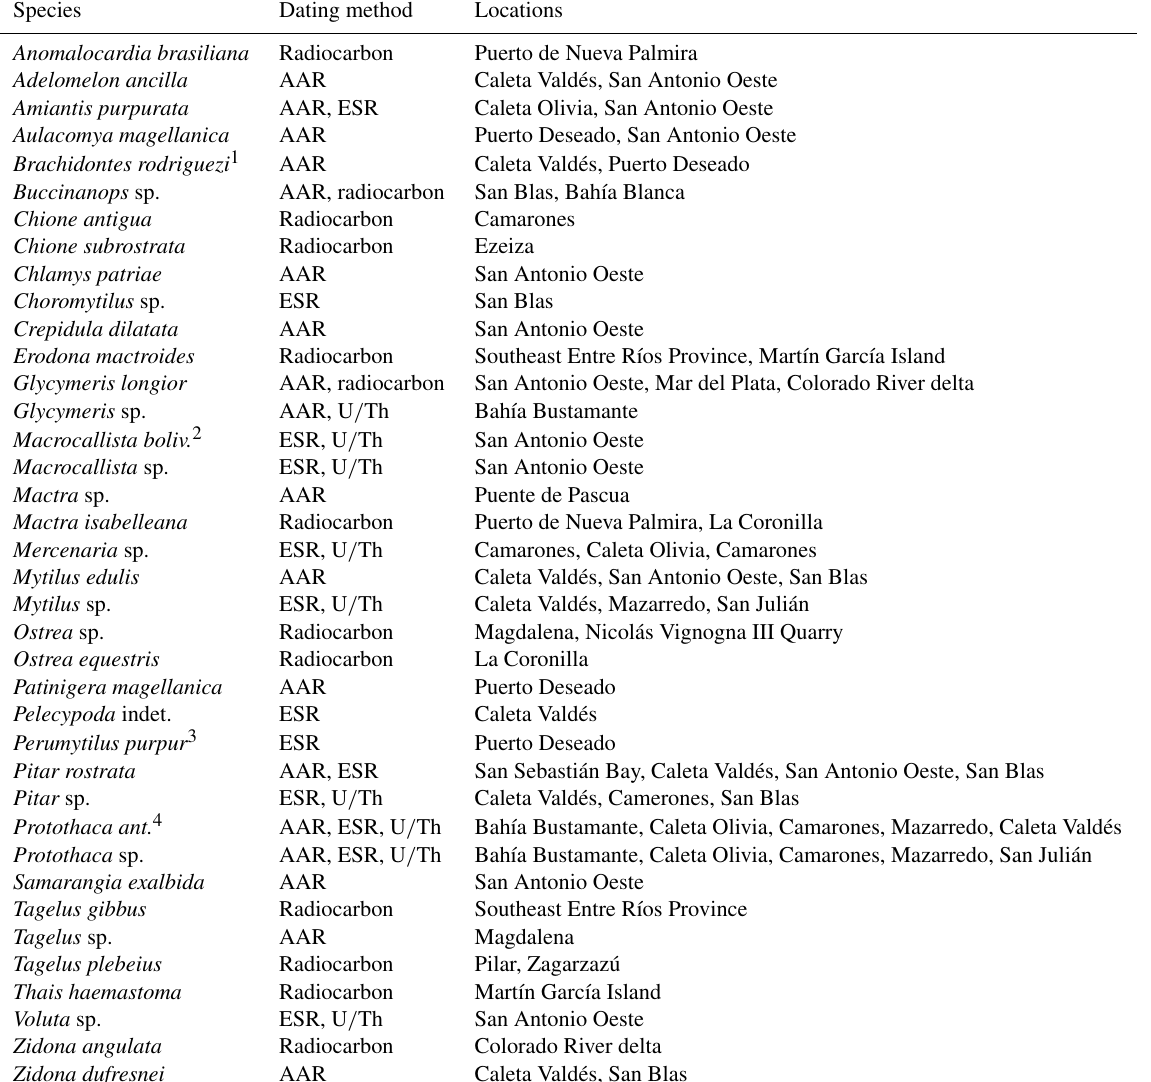
Table 7. Species of shells that have been dated in southeastern South America. Names are as reported in the original papers.